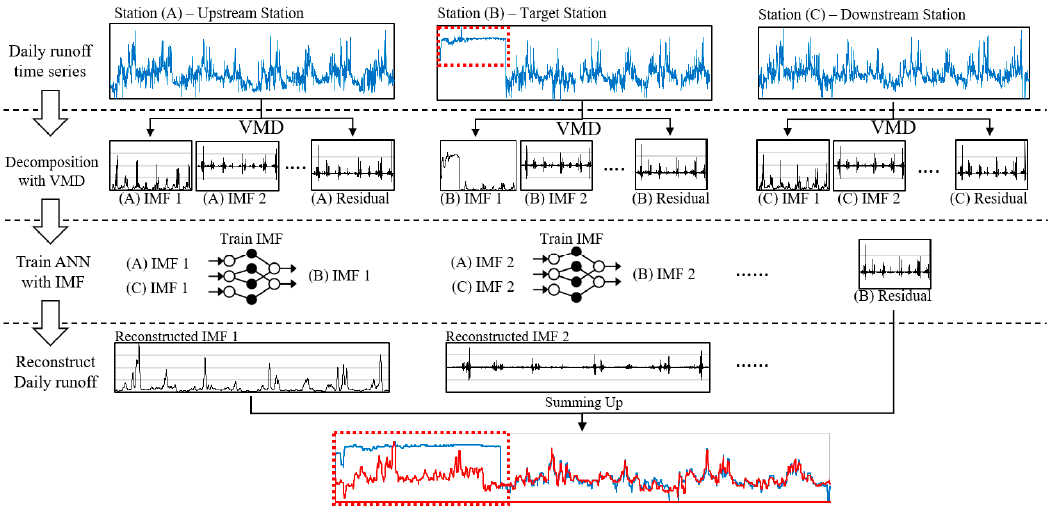
Figure 2. Overall framework of the reconstruction method for daily runoff time series with three stages: ( i ) decomposing runoff series, ( ii ) training an artificial neural network (ANN) using intrinsic mode functions (IMFs), ( iii ) summing up each reconstructed IMF and residual.